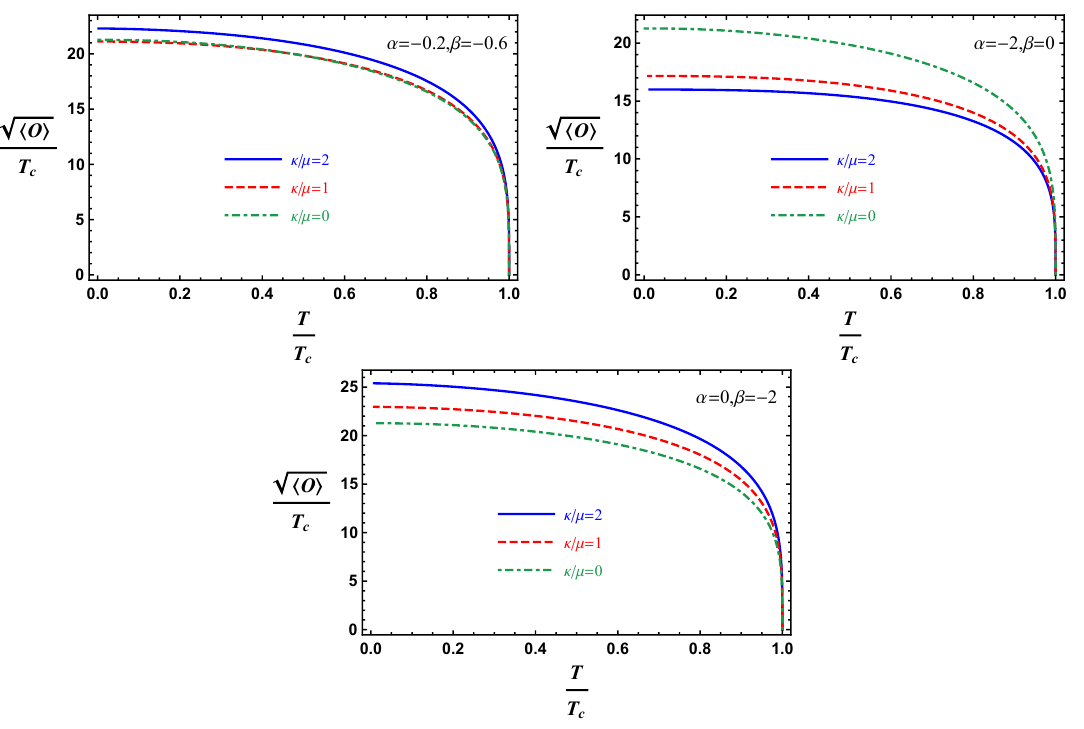
Figure 1 . The value of the condensate as a function of the temperature in various configurations of the massive